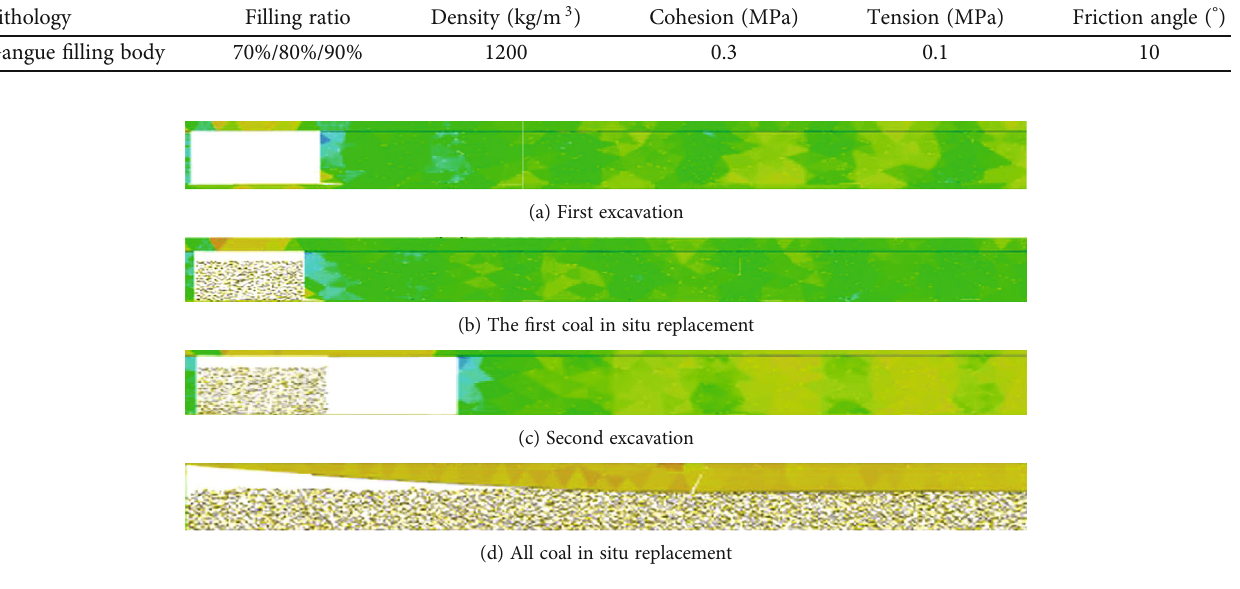
Figure 7: Coal seam mining and in situ